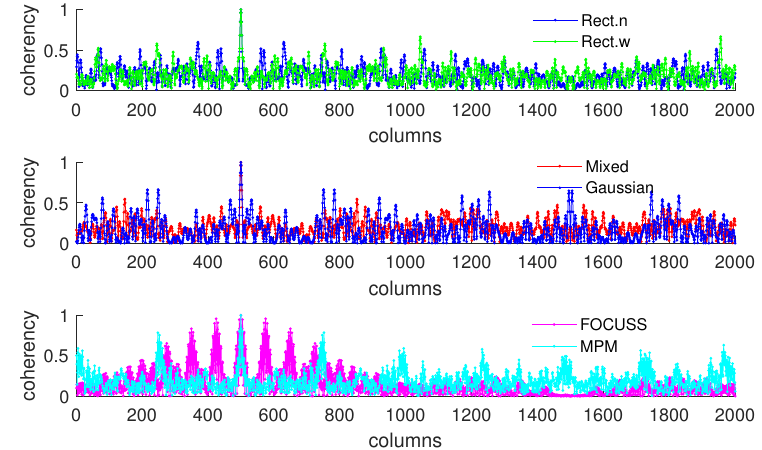
Figure 16. Coherence curves in each subarray generated in Simulation 4 at direction θ = π